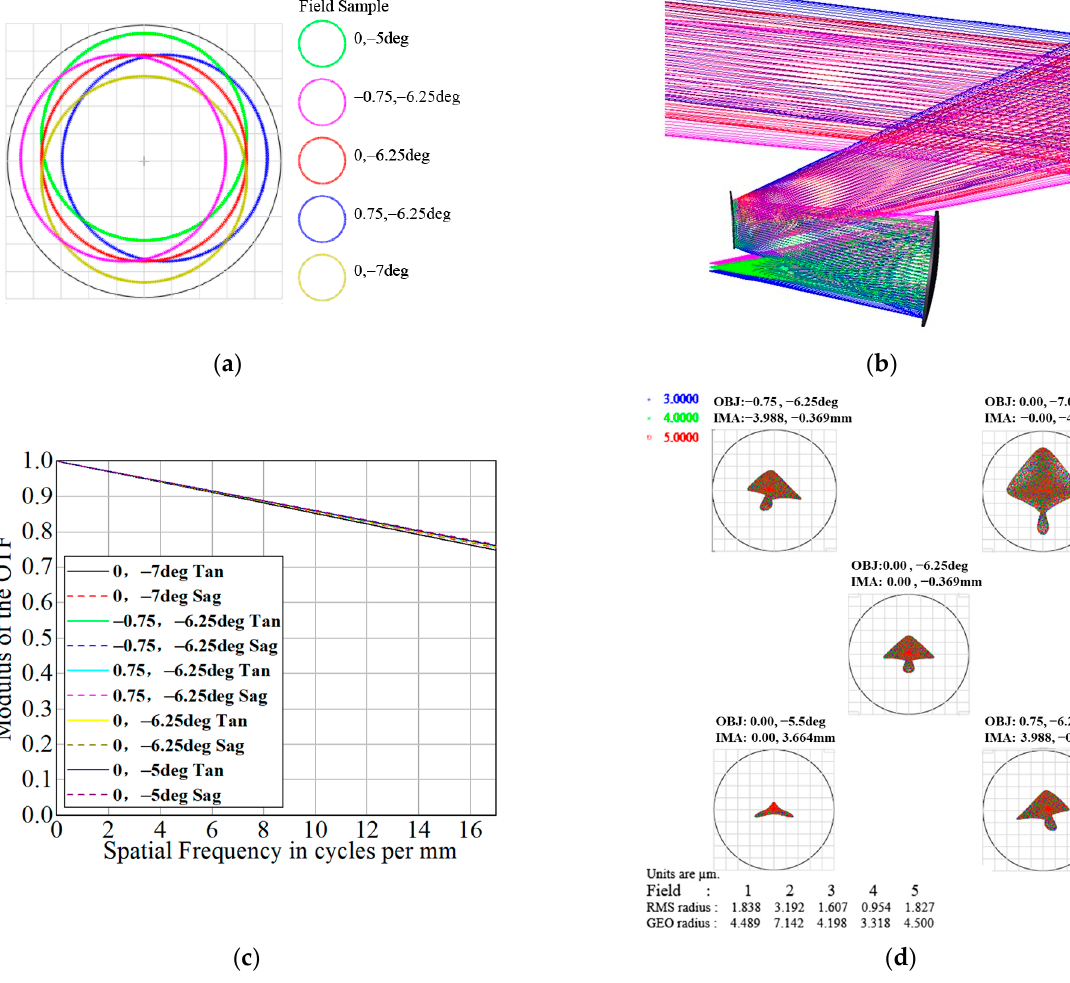
Figure 11. RSIS design results: ( a ) RSIS FOV distribution; ( b ) RSIS layout; ( c ) MTF of RSIS; ( d ) the full field spot diagram of RSIS.